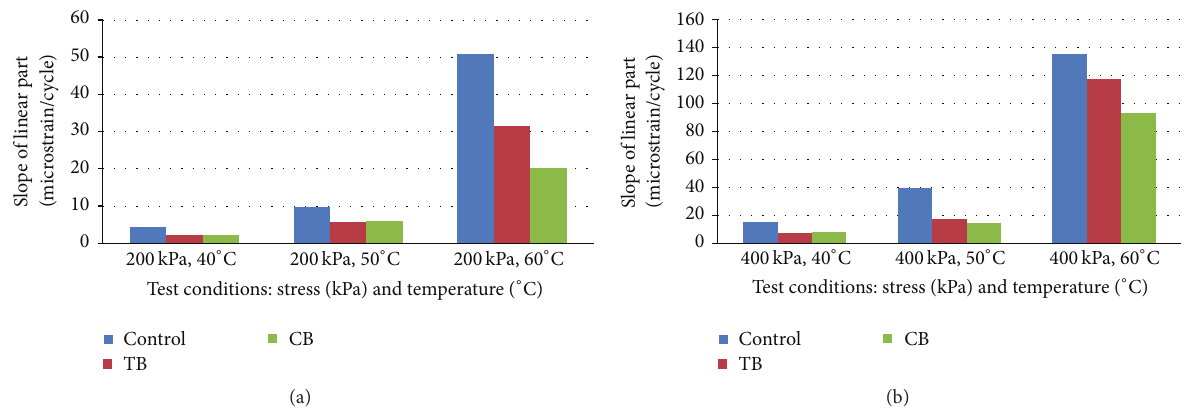
Figure 8: (a) Slope of secondary stage for control and rubberized asphalt mixtures at different temperatures tested at 200 kPa. (b) Slope of secondary stage for control and rubberized asphalt mixtures at different temperatures tested at 400 kPa.